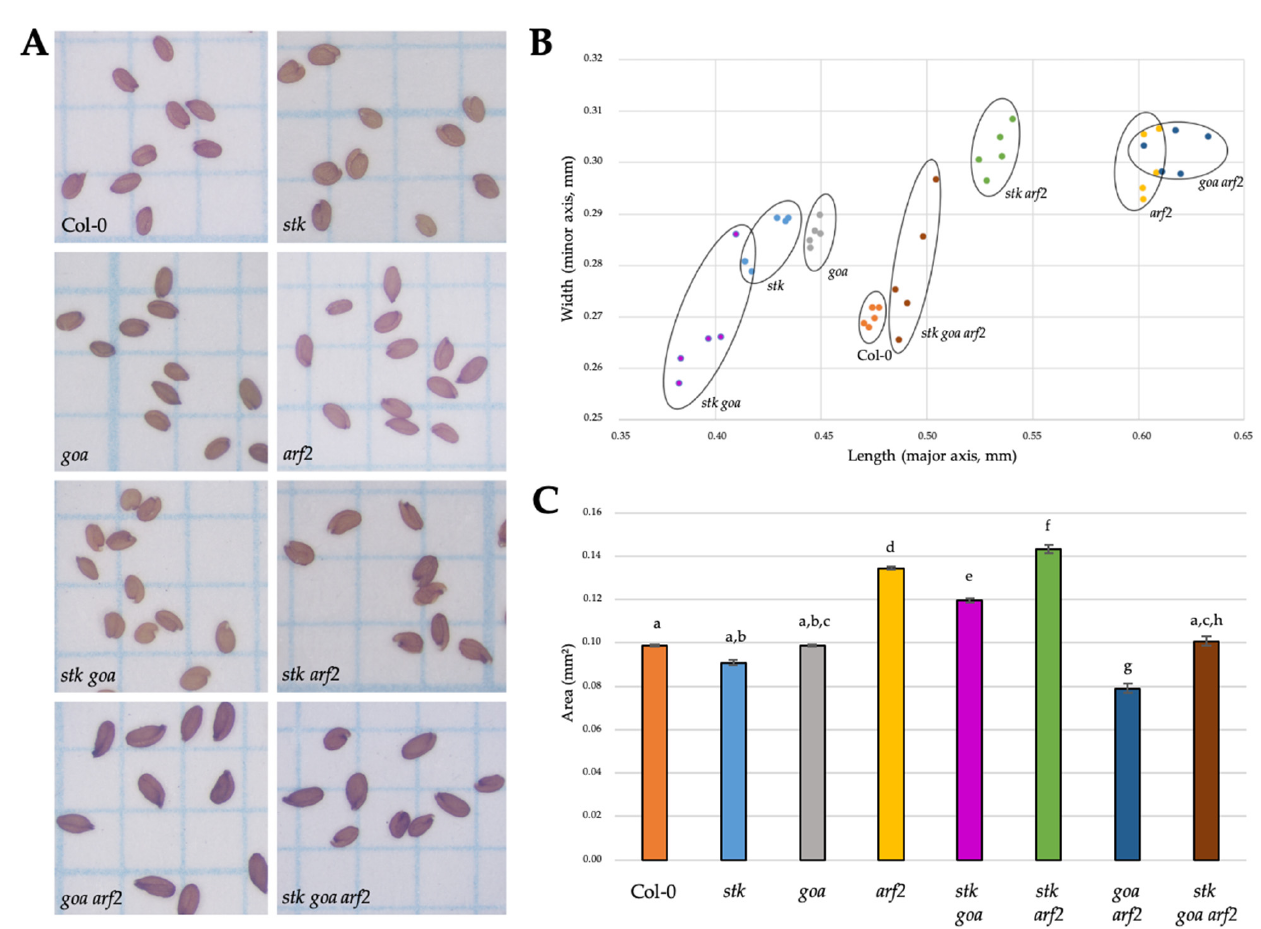
Figure 1. Size comparison of mature seeds. ( A ) Comparison of mature seeds three weeks after manual pollination of wild type Col-0, stk , goa , arf2 , stk goa , stk arf2 , goa arf2 and stk goa arf2 plants with pollen of the same genotype. ( B ) Data distribution of mature seeds based on length (major axis) and width (minor axis). Each dot represents a biological replicate with a mean of at least 50 seeds coming from a single parent. Five biological replicates were produced from populations coming from independent parental lines and similar values were obtained. ( C ) Seed area of different mutants combination. Values represent the average area (mm 2 ) of 10 biological replicates with at least 100 seed measurements for each genotype. Error bars represent s.e. of the sample. Letters above the bars display statistical differences based on Tukey HSD test at p ≤ 0.05.